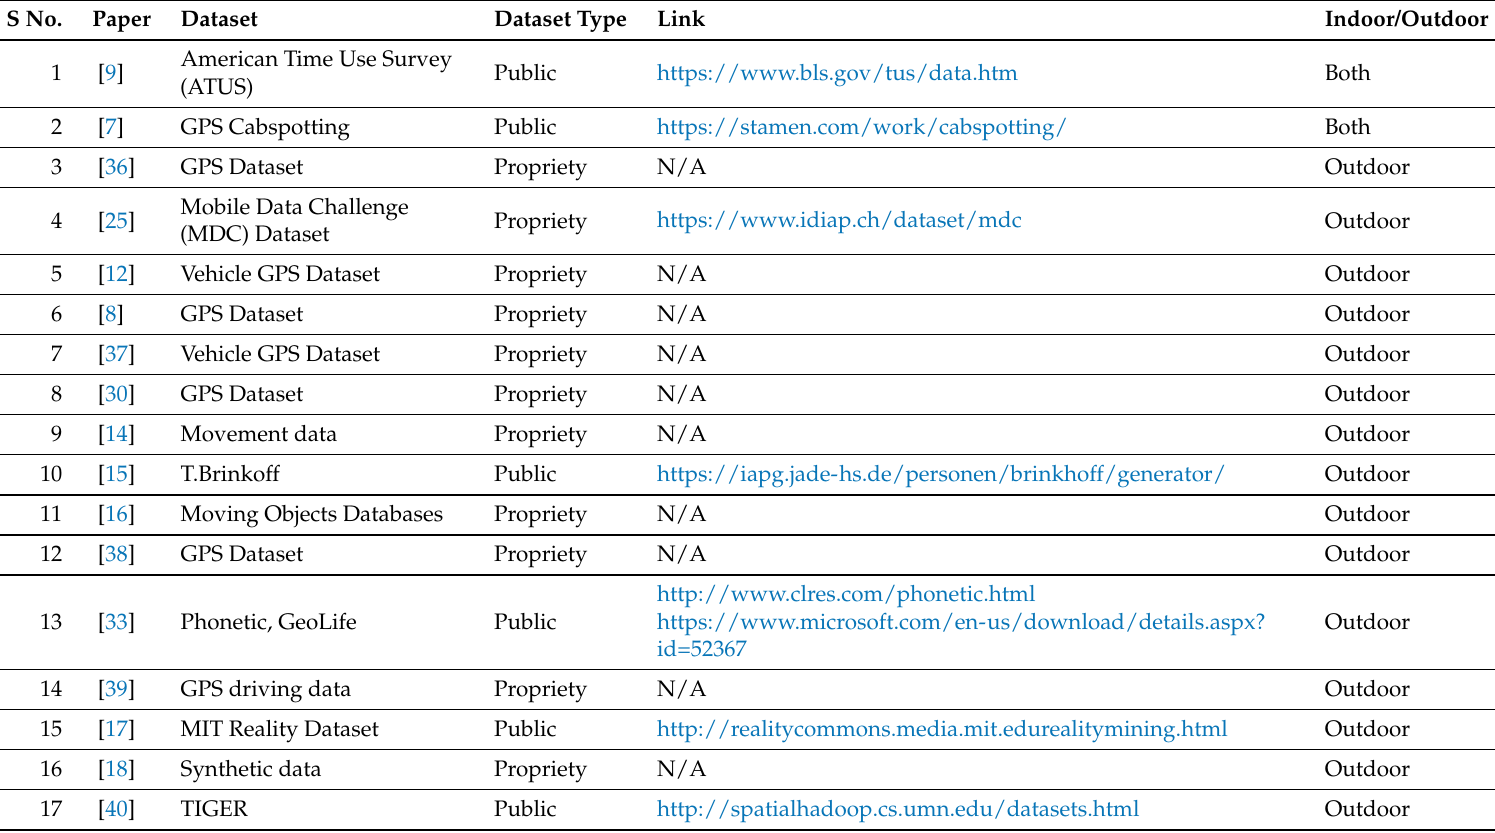
Table 1. Public and Proprietary